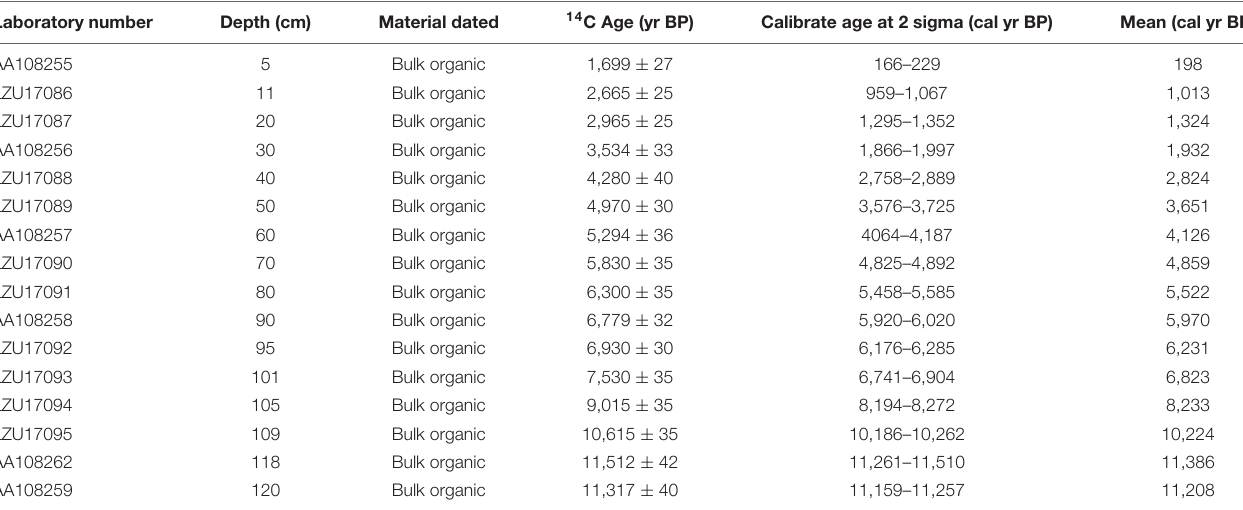
TABLE 1 | AMS 14 C dates and their calibrated ages from the upper 1.26 m of core DYH16A from Daye